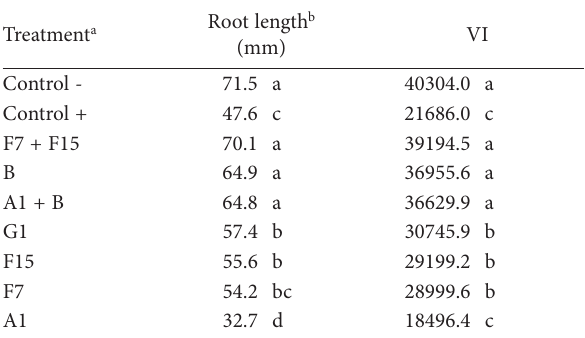
Table 5. Mean “Simeto” seedling root lengths and seedling vigour indices (VI) for seedlings were grown from seeds treated with dif- ferent bacterial endophyte treatments and artificially inoculated with Fusarium culmorum .